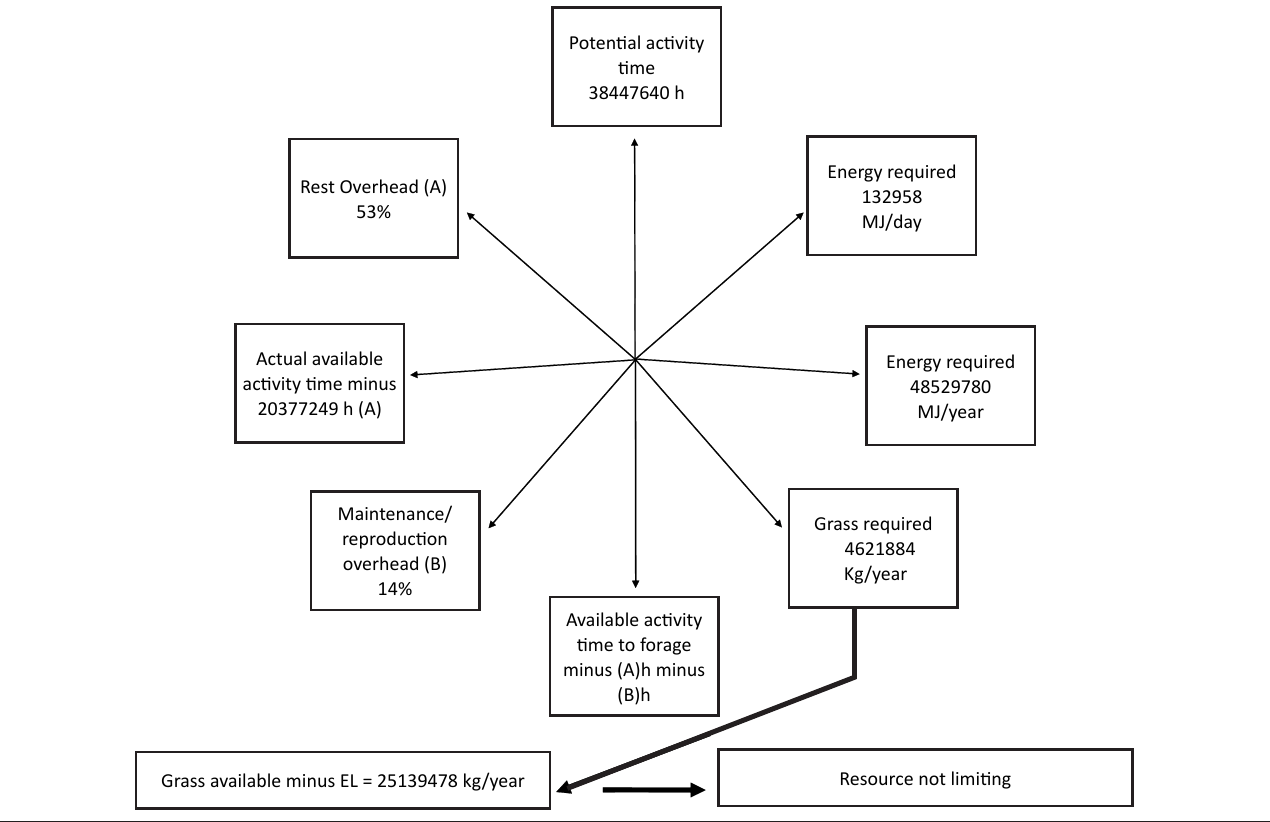
FIGURE 8: The capacity of the grazing resource, presented as the amount of grass required versus that available to provide sufficient energy to a game population of known